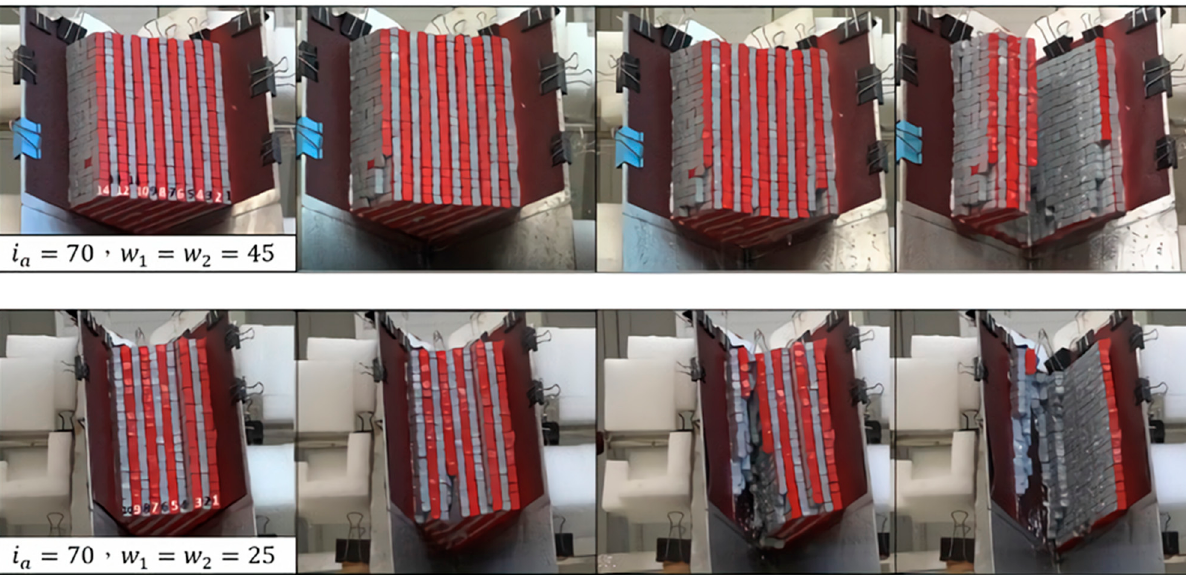
Figure 14. Comparison of tests with i a = 70° and different ω